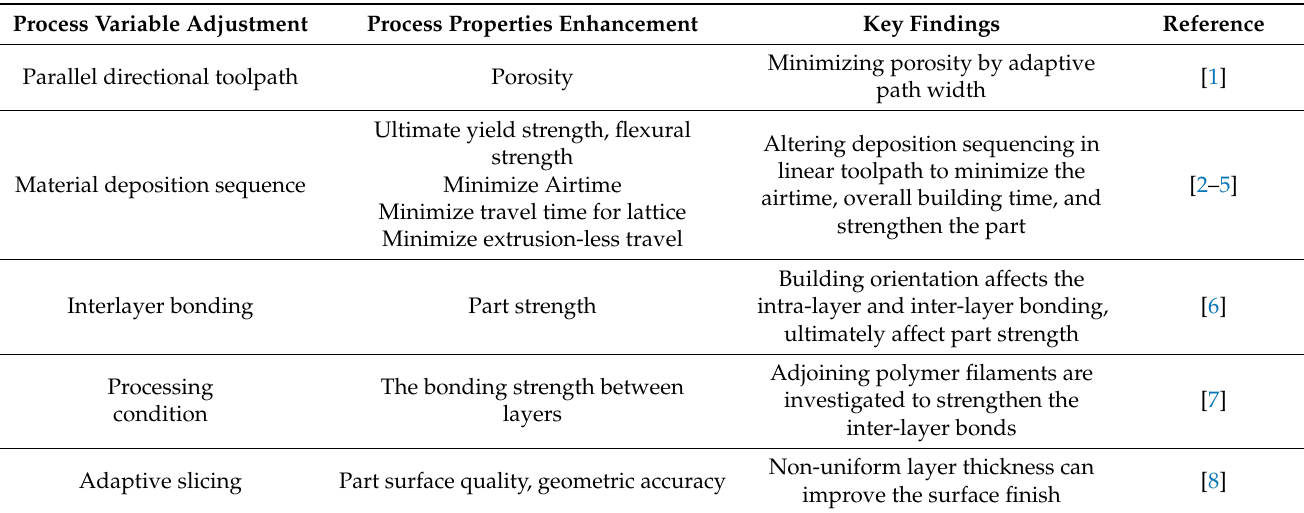
Table 1. Optimization Strategies in FFF processes.